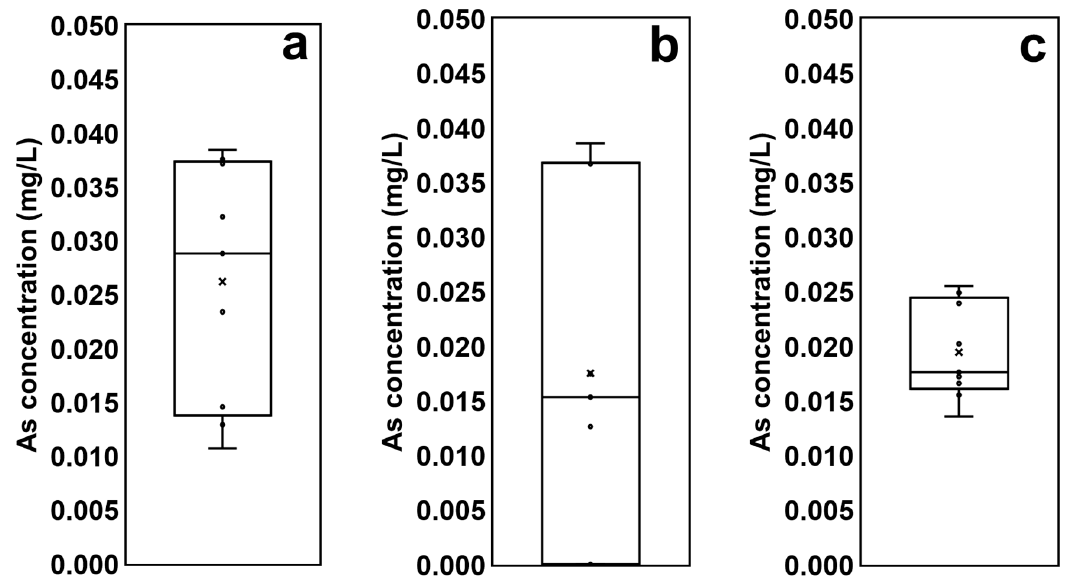
Figure 4. Comparison of arsenic concentrations derived from the batch-leaching test: ( a ) the reservoir sediment; ( b ) the agricultural land soil; ( c ) the stream sediment.